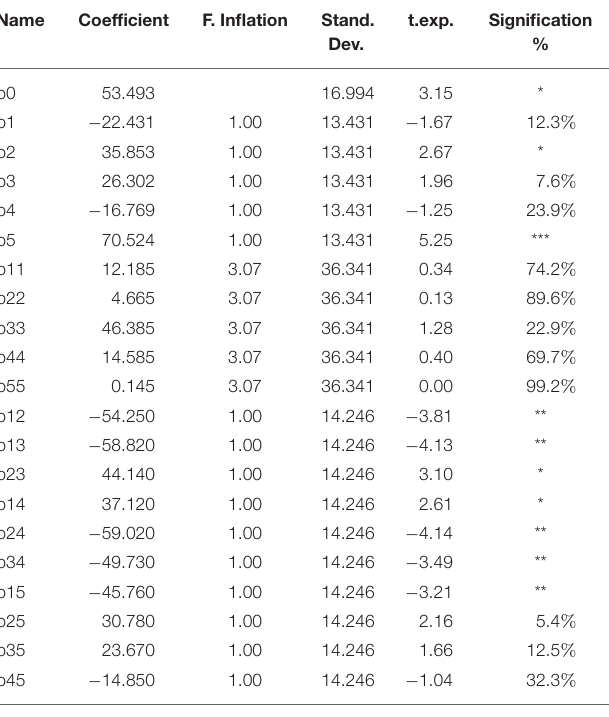
the release of iron-chelating pyoverdines (Beneduzi et al.,